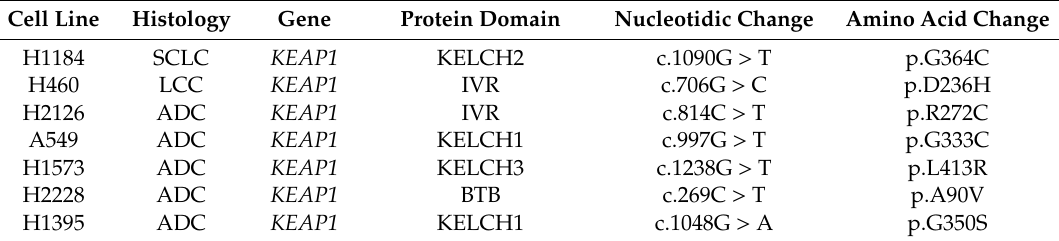
Table 4. Genetic alterations of KEAP1 gene identified in lung cell